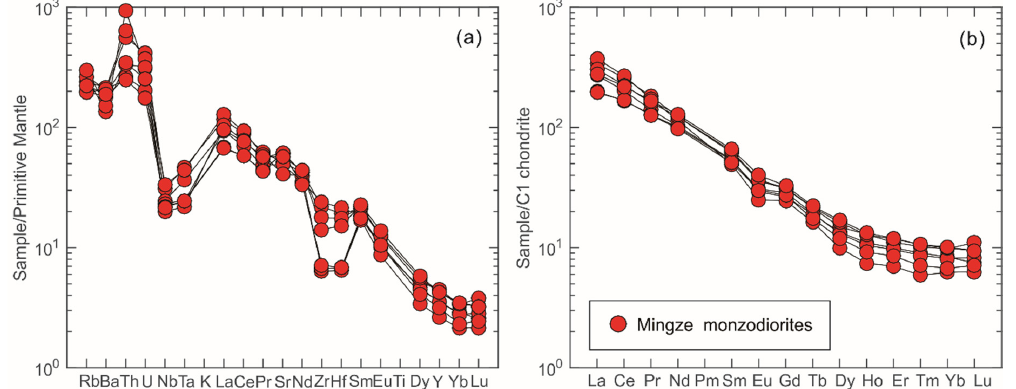
Figure 5. Primitive-mantle-normalized multi-element spider grams ( a ) and Chondrite-normalized rare earth element (REE) patterns ( b ) of the Mingze monzodiorites. Chondrite-normalized and primitive-mantle-normalized values are from